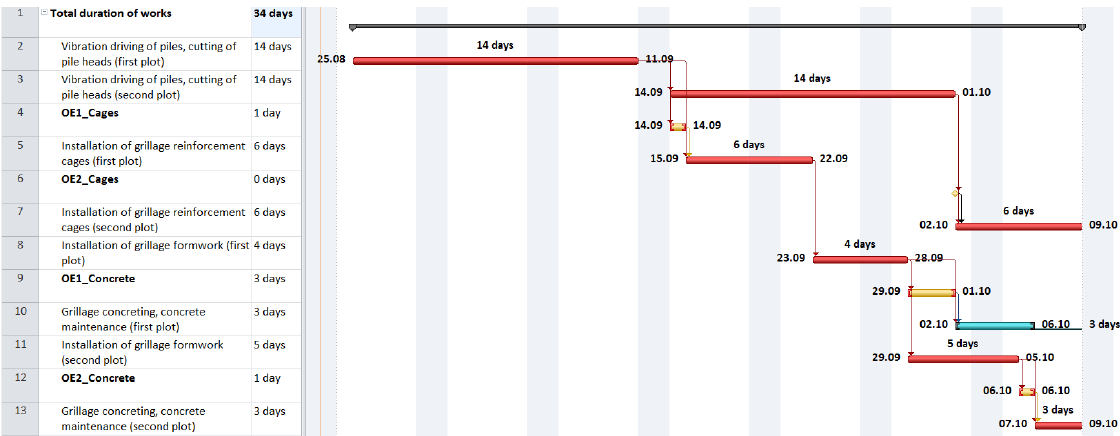
Figure 5. The work schedule option that is 34 days long. Table 1. Optimal schedules.